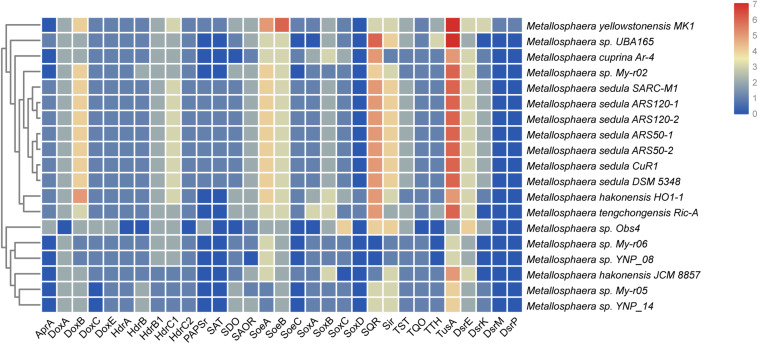
Heat map showing the distribution and numbers of genes encoding putative proteins in sulfur metabolism in various Metallosphaera strains. AprA, APS reductase; SAT, ATP sulfurylase; TST, thiosulfate sulfurtransferase; SDO, sulfur dioxygenase; DoxA/DoxD, thiosulfate:quinone oxidoreductase subunits; Sir, sulfite reductase; TTH, tetrathionate hydrolase; HdrA/HdrB/HdrC, heterodisulfide reductase complex subunits; PAPSr, phosphoadenosine phosphosulfate reductase; SQR, sulfide:quinone oxidoreductase; SoeABC, sulfite-oxidizing enzyme; CbsAB/SoxNL, terminal oxidase complex; DoxE, sulfocyanin; MCO, multicopper blue protein; doxBCE, terminal oxidase complex; TusA/DsrE, cytoplasmic sulfur trafficking proteins.